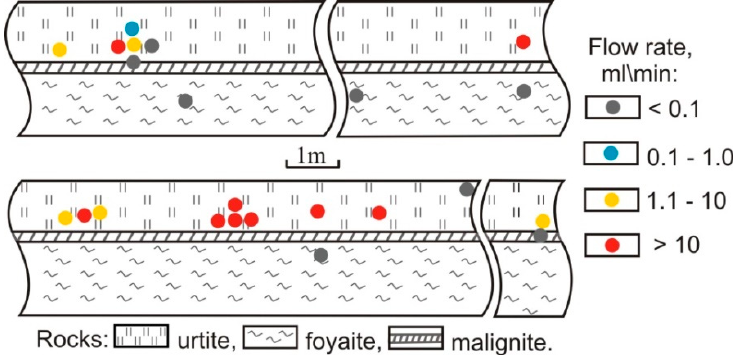
Figure 6. Position of horizontal shot-holes with various free gas (FG) flow rates in the walls of Drift 8/25 (up) and Roadway 23-Eastern (down), Karnasurt Mine, Lovozero loparite deposit (from [18], with modifications).